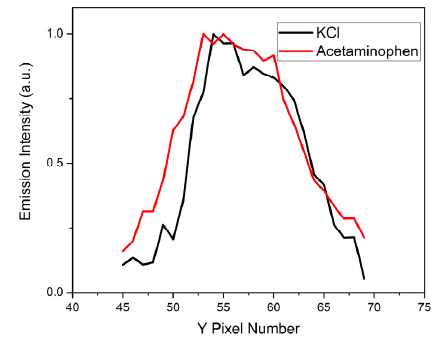
Figure 15. C alibration-corrected LWIR LIBS emission profiles of KCl (black) and acetaminophen (red) in the direction perpendicular to the grating dispersion.